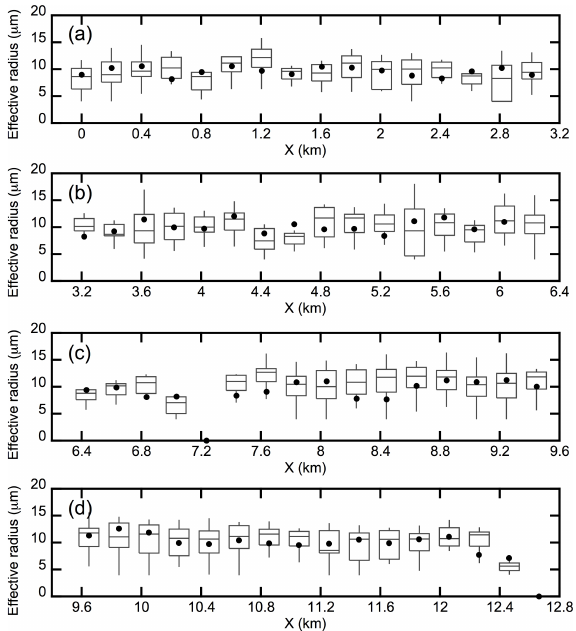
Fig. 7. Box plots of the effective radii at locations along the dashed Fig. 7 . Box plots of the effective radii at locations along the dashed line located at 3.1 km in 3 line located at 3.1km in the Y direction, as shown in Fig. 4. (a– the Y direction, as shown in Fig. 4. (a–d) are one continuous plot broken into four panels. 4 d) are one continuous plot broken into four panels. Dots are the corresponding Dots are the corresponding retrievals. 5